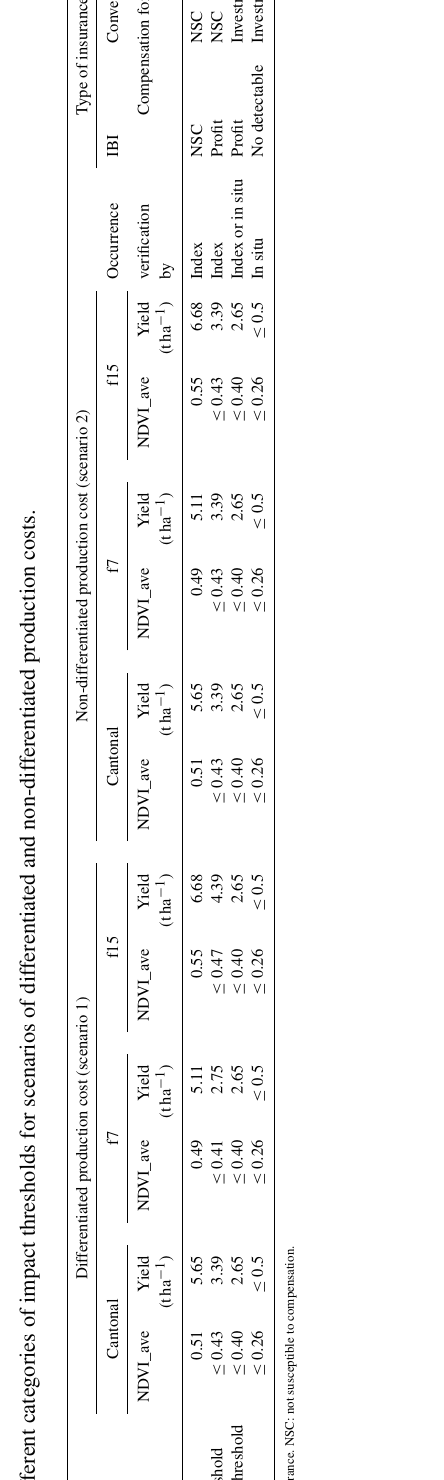
For the economic threshold, the indemnity calculation (USD 840 ha − 1 ) for cantonal zones is equal in both scenar- ios 1 and 2, as shown in Table 7, because we used the same weighted average as production cost (USD 1259 ha − 1 ). For f7 a higher gross margin is expected in scenario 1 than in scenario 2 due to scenario 2’s production cost being higher. On the contrary, for f15 the gross margin is higher in sce- nario 2 than in scenario 1 because in scenario 2, f15 has a lower production cost than in scenario